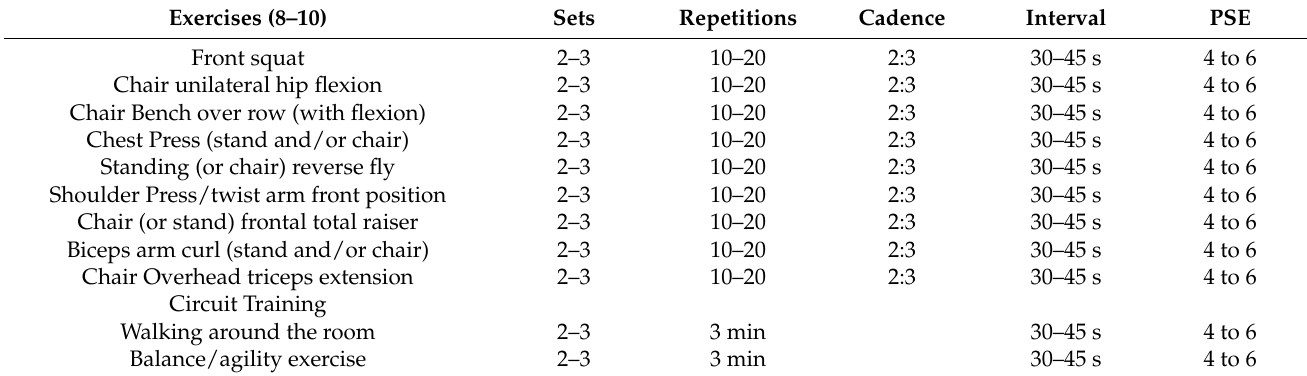
Table 2. Example of multicomponent exercise sessions applied in phase